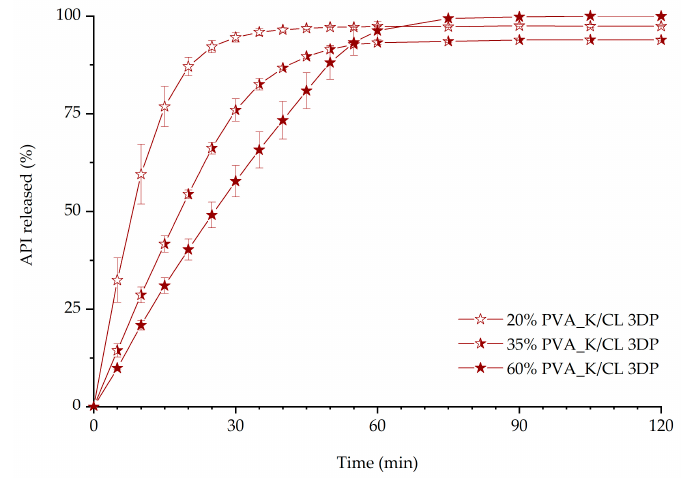
Figure 10. The influence of infill percentage on dissolution profiles of itraconazole from 3DP tablets.